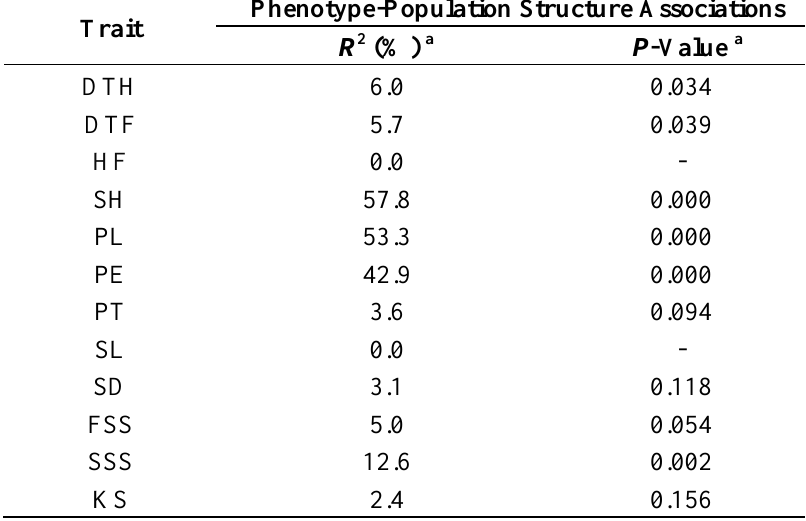
Table 4. Relationship between phenotypic traits and population structure computed using the mean values across